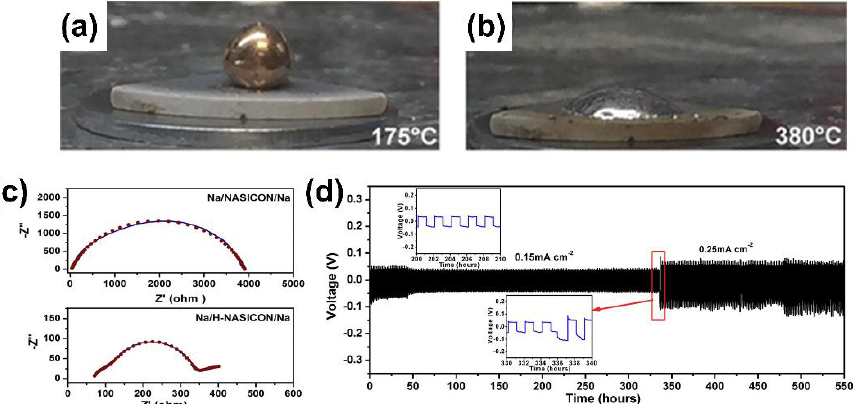
Figure 2. The optical photos of sodium metal on NZSP pellets ( a ) at 175 °C and ( b ) 380 °C. ( c ) The impedance plots of Na||NASICON||Na and Na||H-NASICON||Na symmetric cell at 65 °C. H-NASICON refers to the pellet sample treated at 380 °C. ( d ) Cycling stability of the Na/H-NASICON/Na symmetric cell at 65 °C (adapted with permission from ACS).